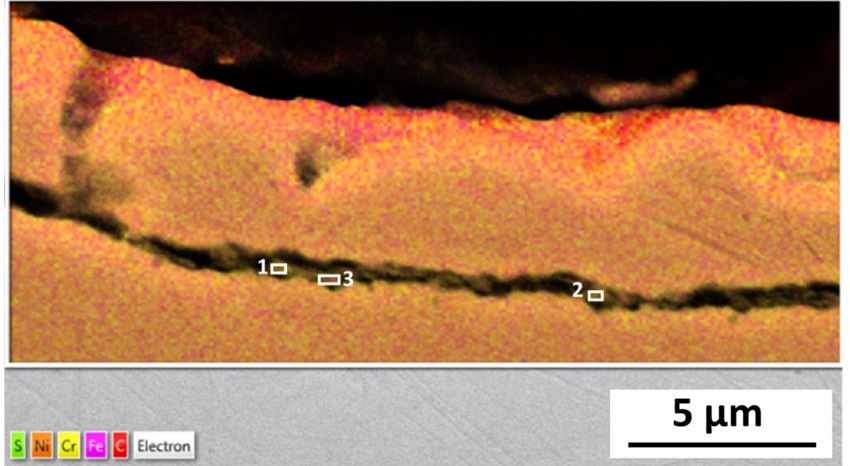
Figure 16. Elemental mapping of within the subsurface crack propagation of 254SMO after Reykjanes exposure, showing the locations of EDX elemental analysis inside the crack. The colour map details the relative elemental composition of S, Ni, Cr, Fe and C in the